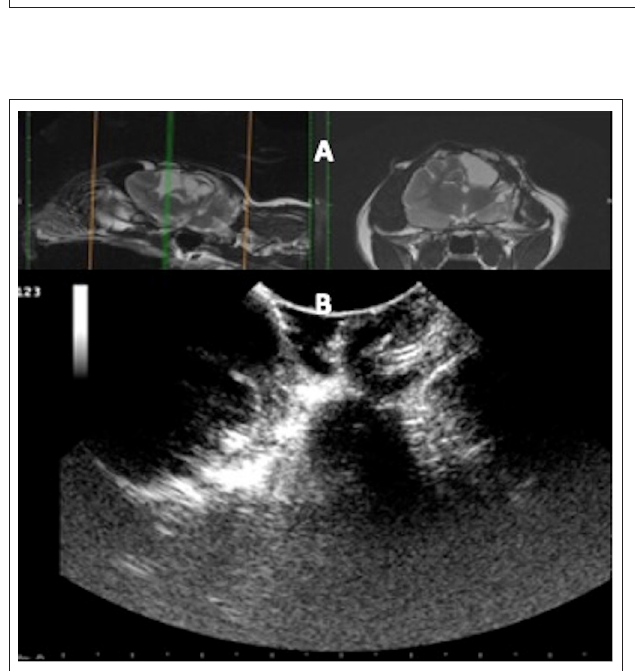
FIGURE 7 | Case 36. (A) Sagittal and transverse magnetic resonance images of a cat that suffered a skull fracture 6 months before presentation and presented for a sudden onset of generalized seizures. The injury site consisted of fluid-filled areas and devitalized cortical tissue. (B) At surgery, the ultrasound identified the fluid-filled areas and adjacent unaffected cerebral tissue.